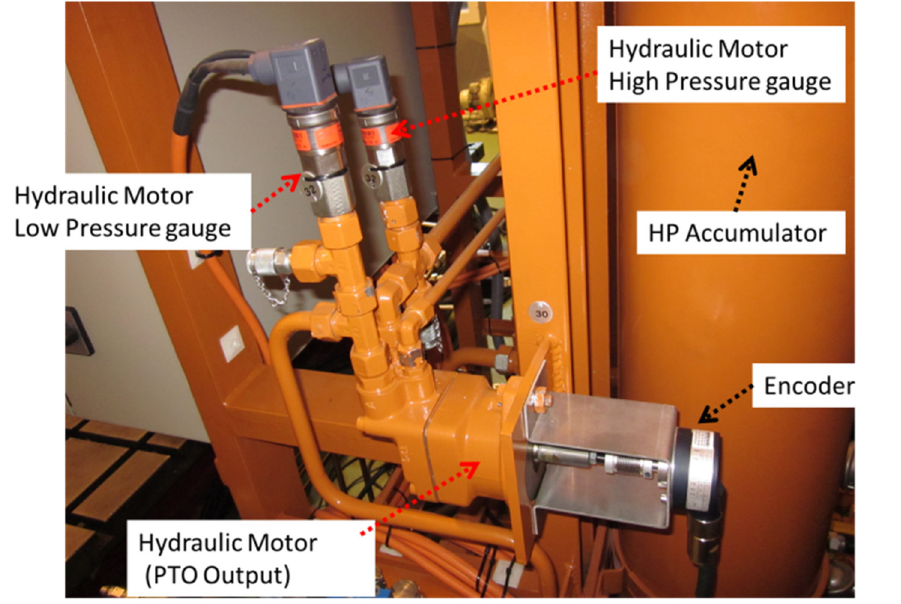
Figure 27. Hydraulic Motor. PTO